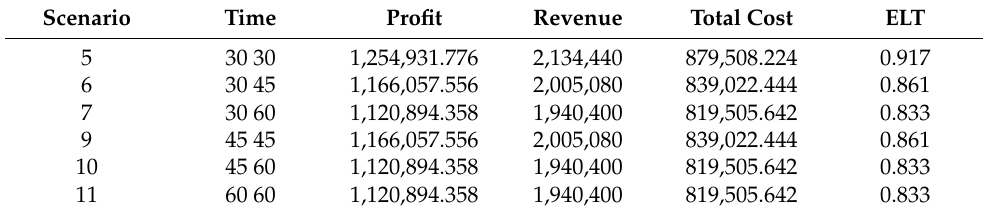
Table 3. The supply chain performance when the epidemic propagates to the